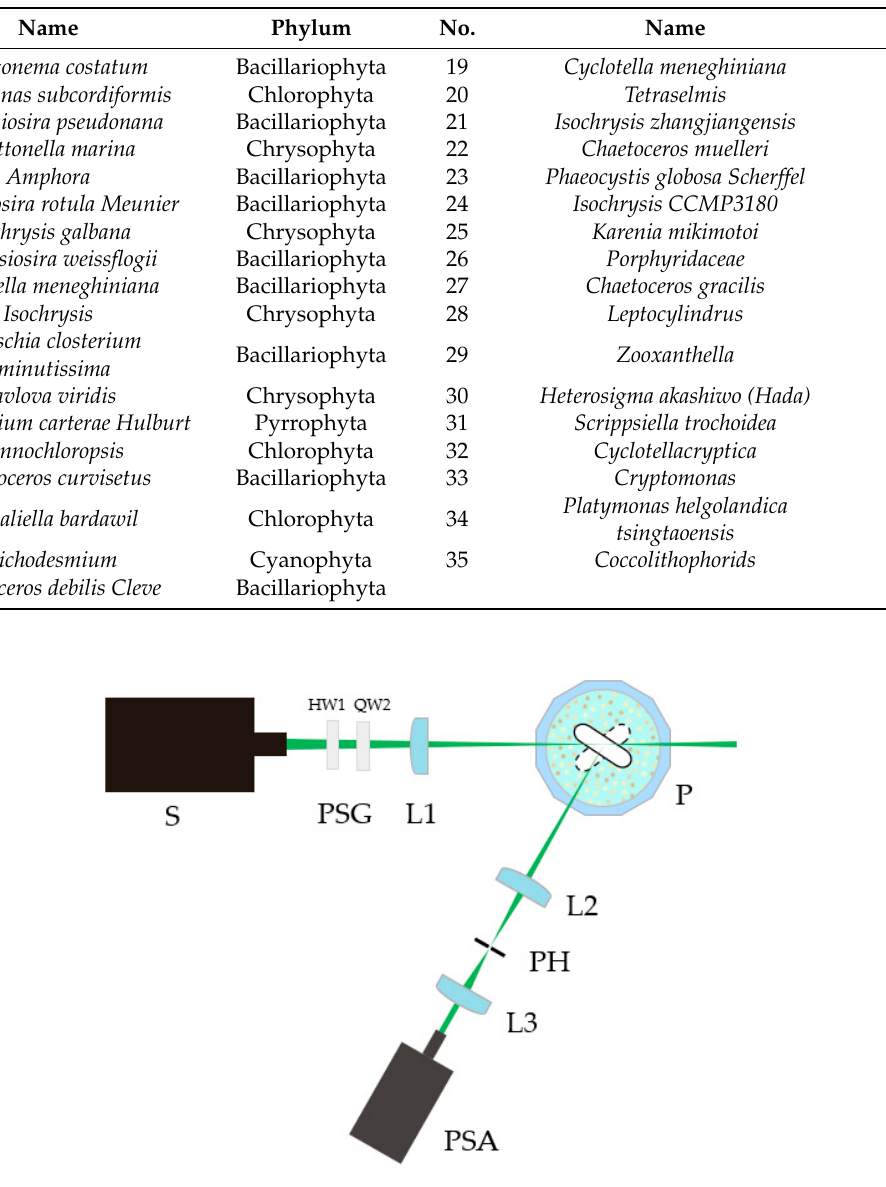
where I is the light intensity, and 𝑄, 𝑈, 𝑉 are the residual intensity of 0° linear polariza- tion, 45° linear polarization, and right-handed circular polarization, respectively. The three normalized polarization parameters, 𝑞, 𝑢, 𝑣 , are defined as Equation (2),